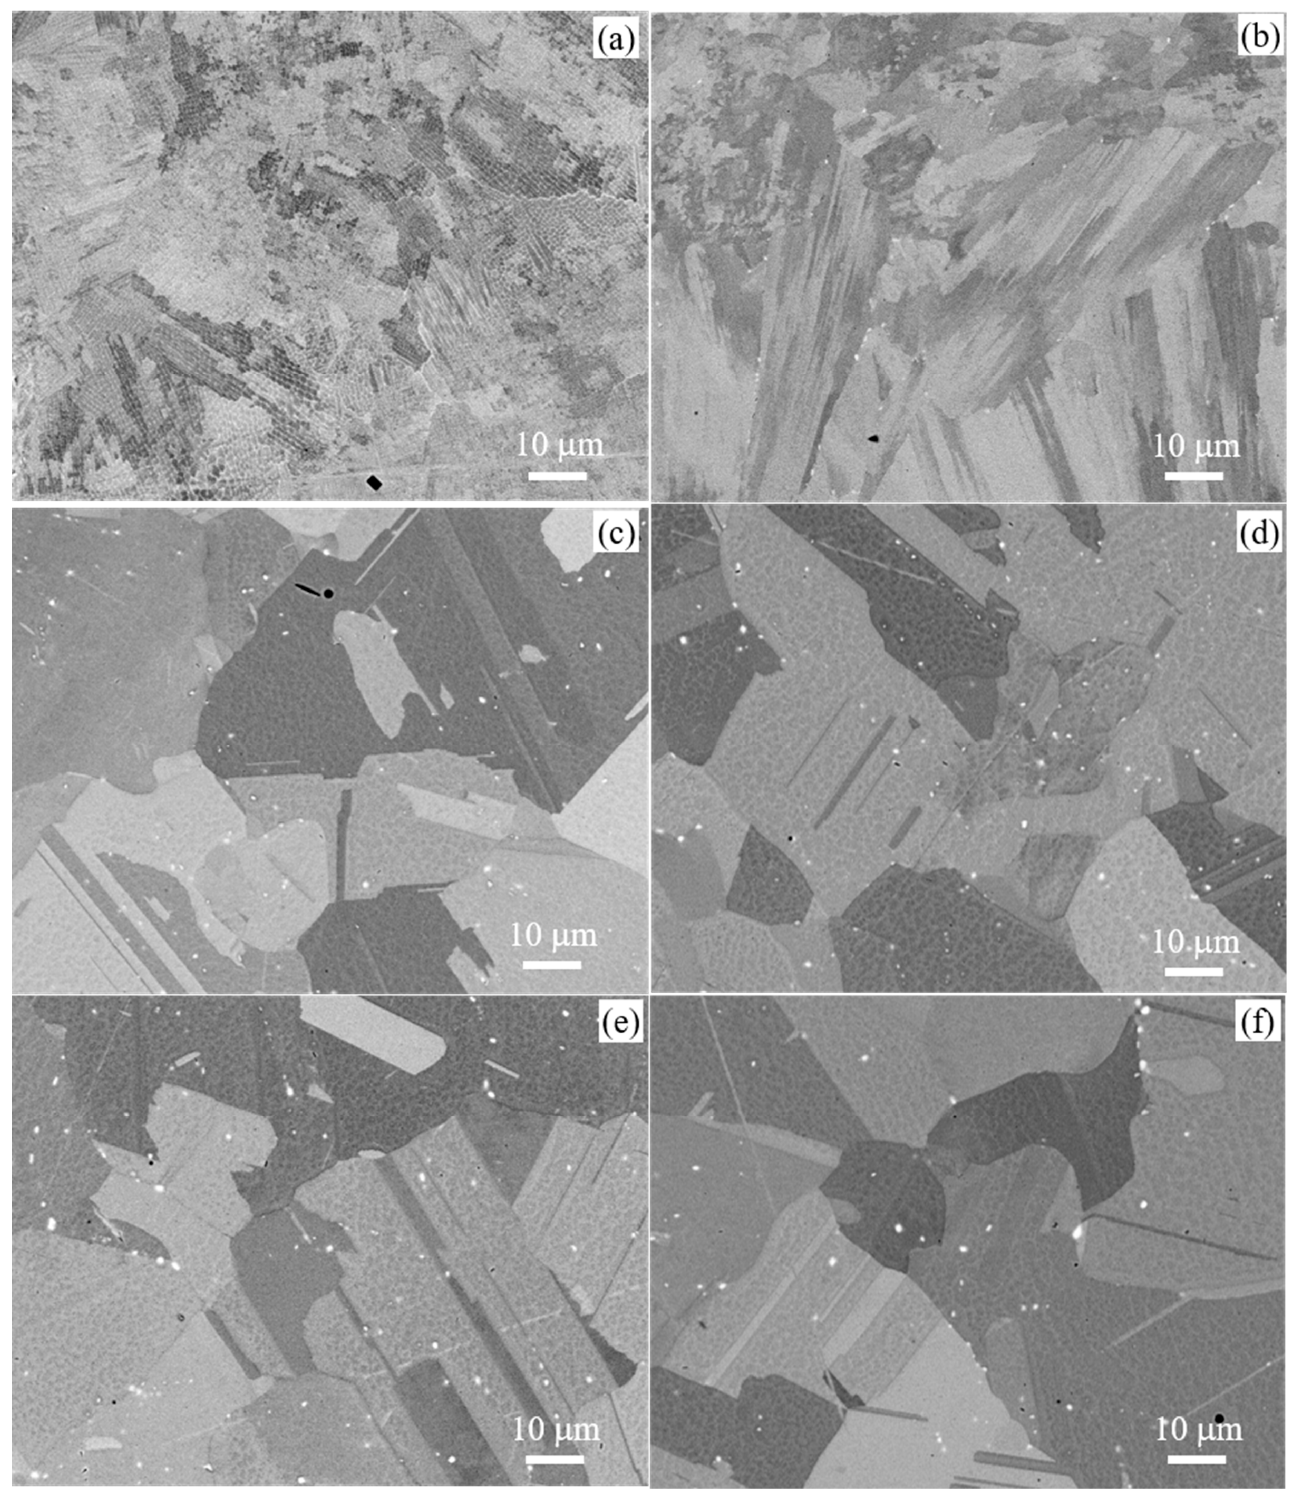
Figure 2. SEM electron backscatter images: ( a ) as-printed, ( b ) ST1 (1100 ◦ C/1 h), ( c ) ST3 (1100 ◦ C/3 h), ( d ) ST6 (1100 ◦ C/6 h), ( e ) ST9 (1100 ◦ C/9 h) and ( f ) ST16 (1100 ◦ C/16 h). The white spots in the images are carbides (mainly NbC) particles; the darker spots are most likely TiN or Al-rich particles, depending on the morphology. Al-rich particles are usually circular in shape (note that all the images were recorded at the same